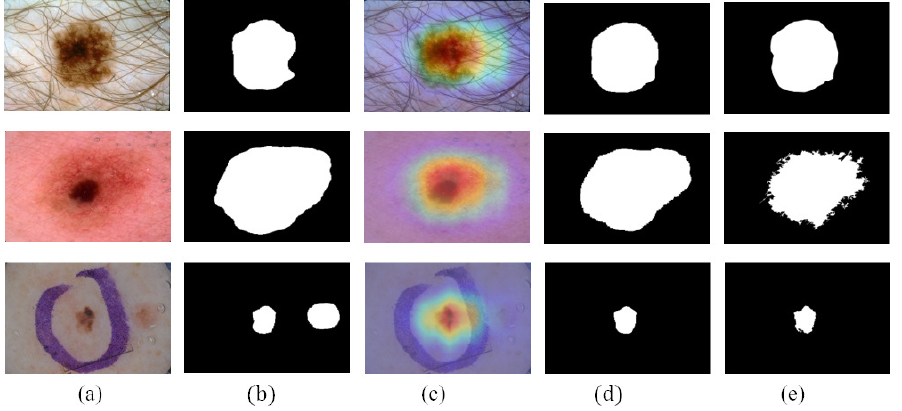
Figure 6. Comparison of the segmentation results obtained by segmentation network with or without using the CAMs: ( a ) dermoscopy images, ( b ) segmentation results obtained when not using CAMs, ( c ) CAMs, ( d ) segmentation results obtained when using CAMs, and ( e ) ground